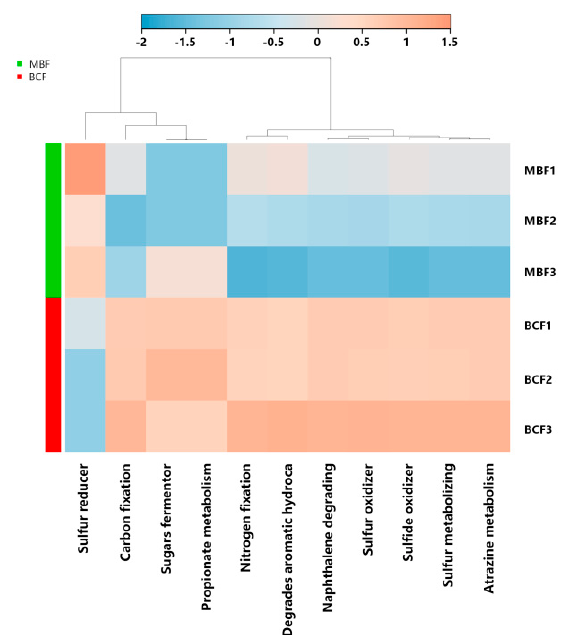
Figure 5. Taxonomic to phenotypic mapping based on the metabolism of bacterial communities associated with the leaves of moso bamboo.